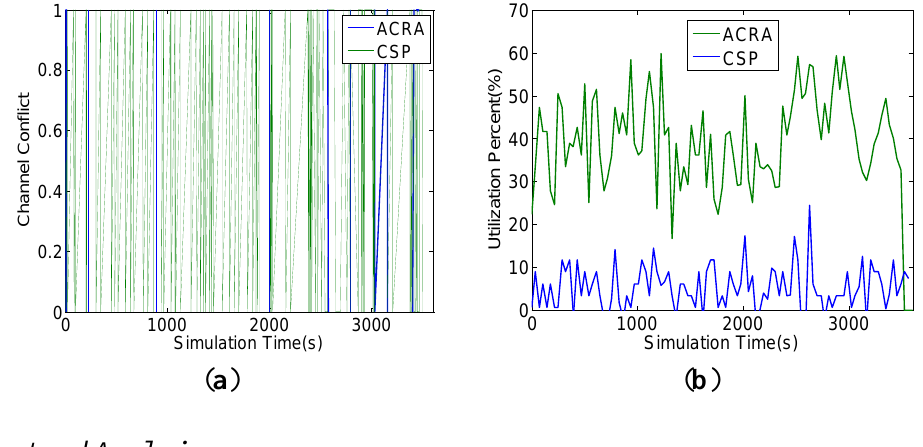
Figure 14. Simulation results of channel status. ( a ) Simulation results of channel conflict; ( b ) Simulation results of channel utilisation.